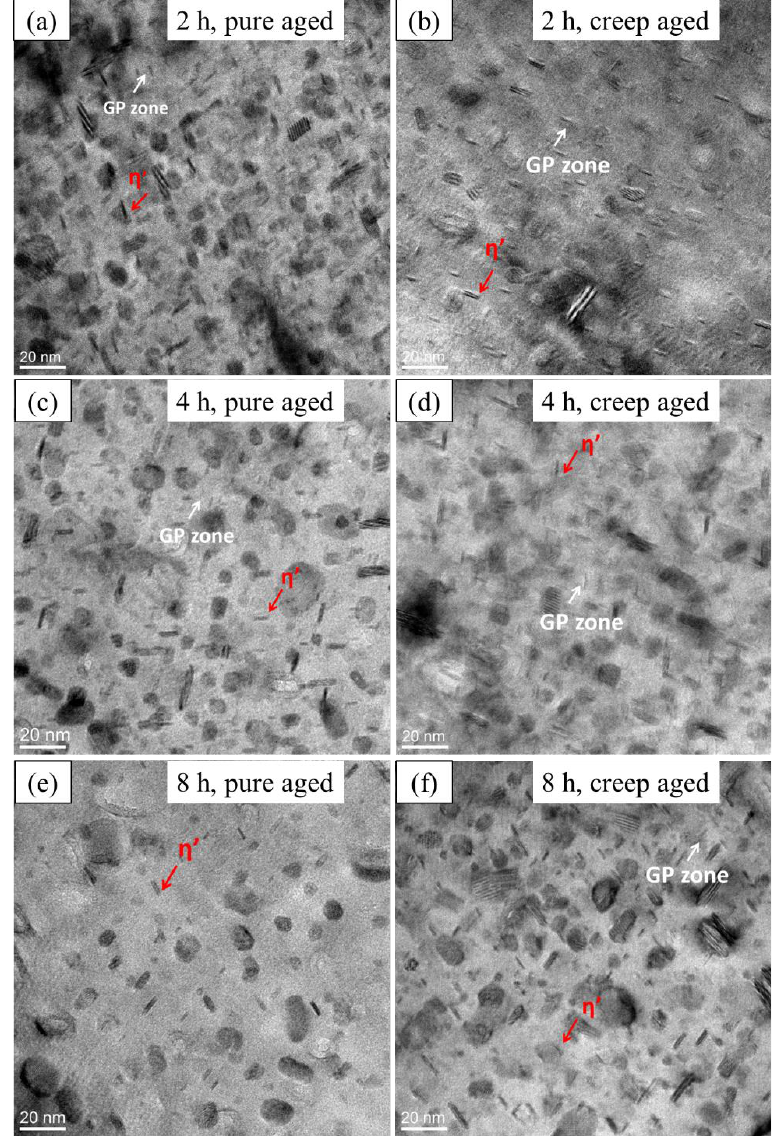
Figure 8. TEM images of 𝜂′ precipitates (red arrows) and Guinier-Preston (GP) zones (white arrows) of specimens pure/creep aged for ( a , b ) 2 h, ( c , d ) 4 h, and ( e , f ) 8 h.